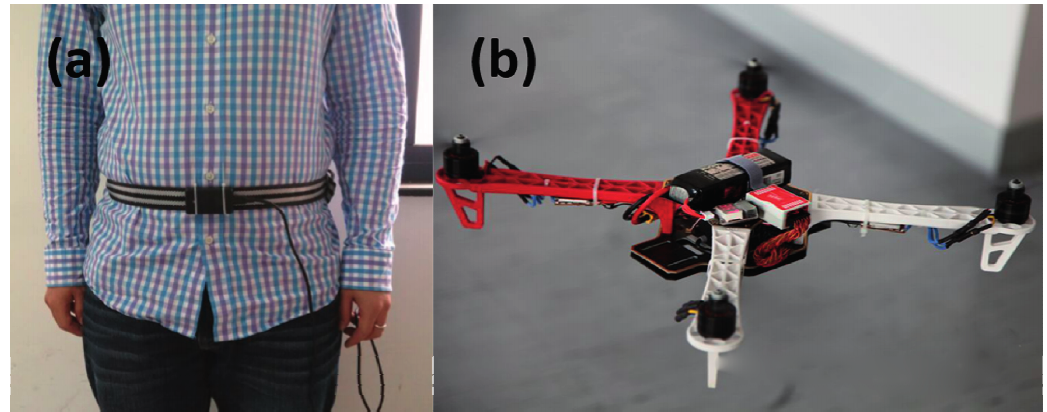
Figure 6. Heading estimation tests with the multi-sensor system ( a ) fixed on the waist of pedestrian; ( b ) fixed on a quadrotor